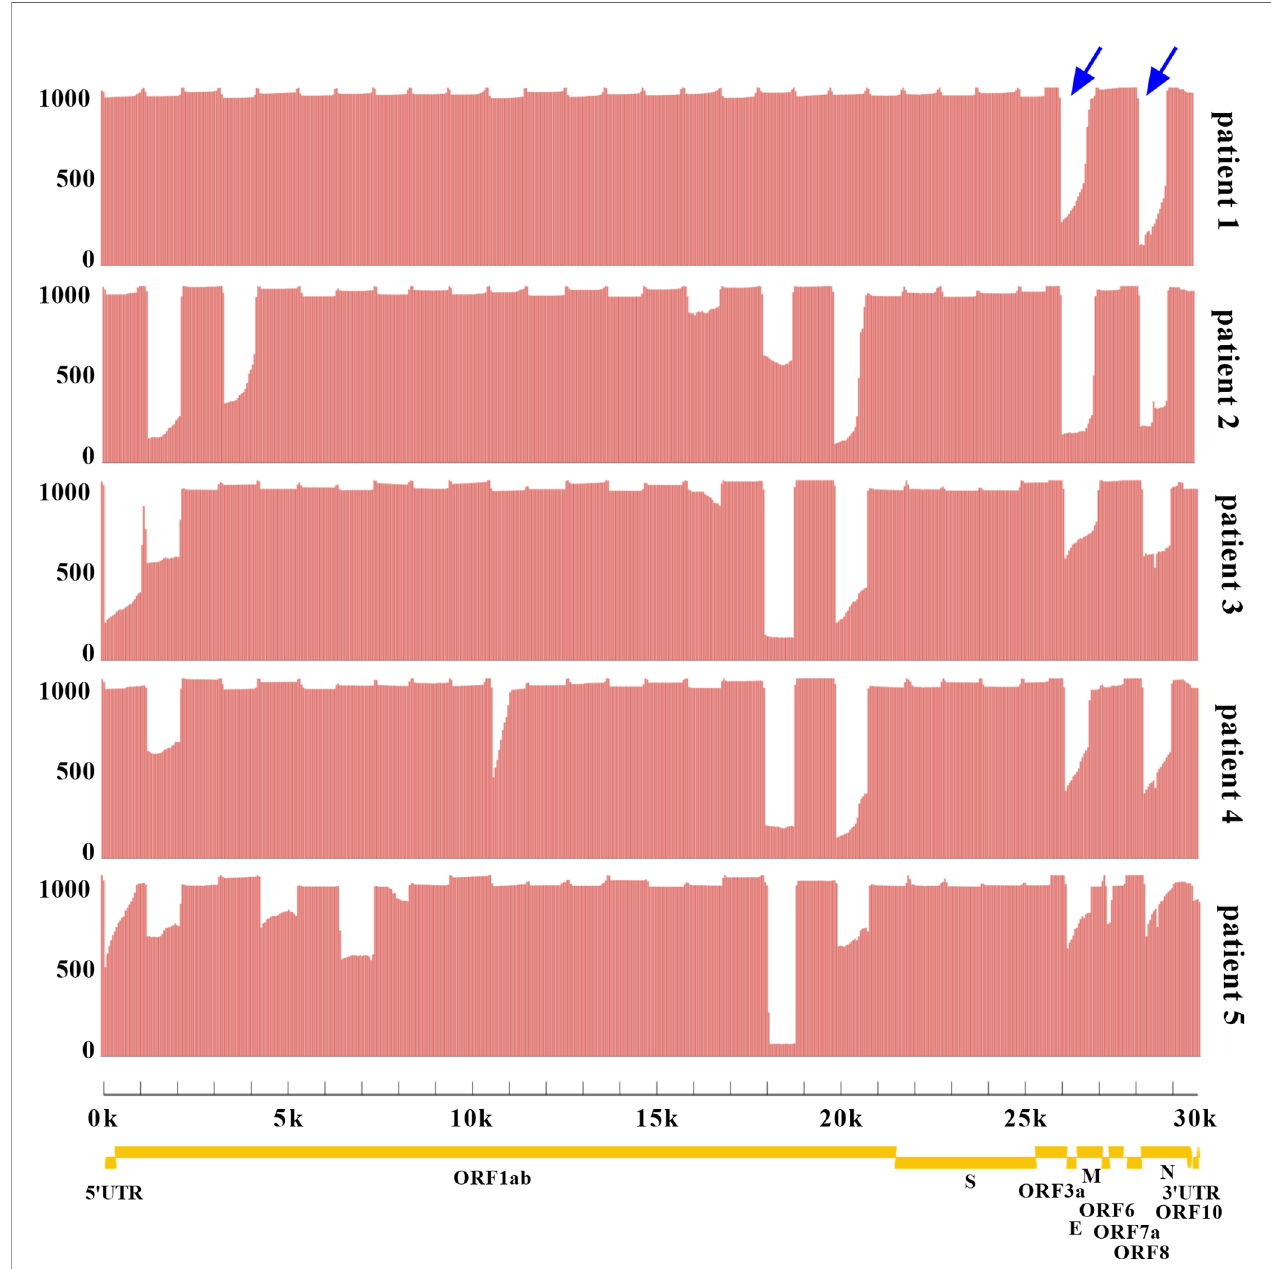
FIGURE 2 | Analysis of sequencing coverage and depth for each SARS-CoV-2 sample. The multiplex PCR products were sequenced with R.9.4.1 fl ow cell. The horizontal axis represented the physical location of SARS-CoV-2 genome from 5 ’ UTR-3 ’ UTR, and the vertical axis represented the sequencing depth of each physical location. The whole genome coverage and depth of each amplicon were shown. Yellow indicated the genes of SARS-CoV-2 encoding structural proteins (S, spike; E, envelope; M, membrane; N, nucleocapsid) and non-structural proteins (ORF1ab, ORF3a, ORF6, ORF7a, ORF7b, ORF8, and ORF10). UTR. untranslated region; ORF, open reading frame. Blue arrows highlighted the amplicons with low sequencing